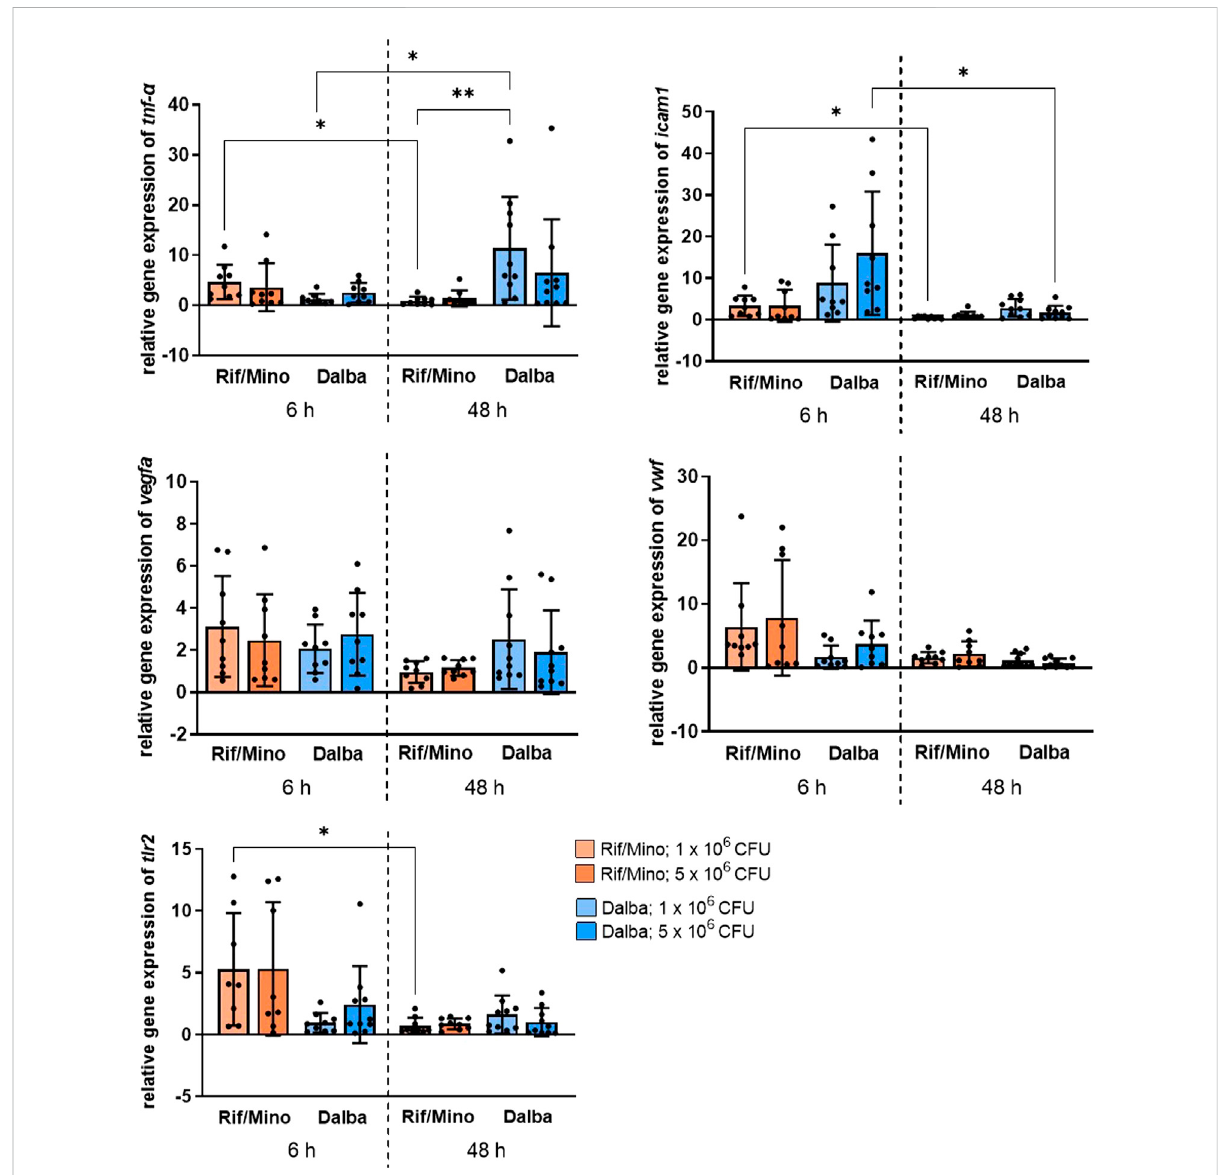
FIGURE 5 Antibiotic activity decreases the local in fl ammatory tissue response towards the contaminated implants. Relative gene expression levels of vegfa , icam1 , tnf- α , vwf and tlr2 were determined by qPCR. Data are represented in scattered dot plots with mean + SD. p values < 0.05 were considered signi fi cant. * p < 0.05; ** p <